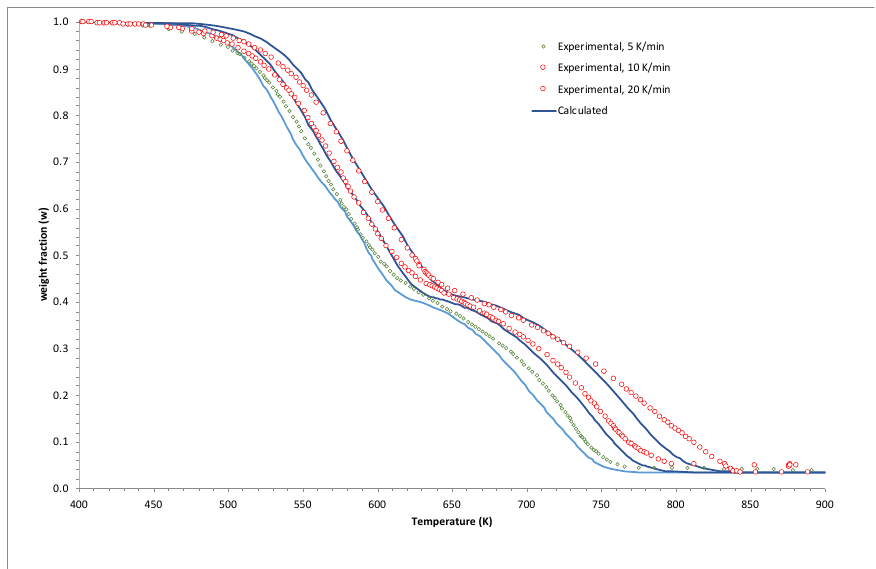
Figure 7. Thermal decomposition of coffee husks at three different HR. Experimental and calculated curves (the kinetic parameters values are: k 01 = 10.6 s − 1 , E 1 / R = 17,673 K, k 02 = 7.26 s − 1 , E 2 / R = 11,919 K, k 03 = 5.1 s − 1 , E 3 / R = 12,566 K, f 10 = 0.26, f 20 = 0.31, all orders were considered equal to